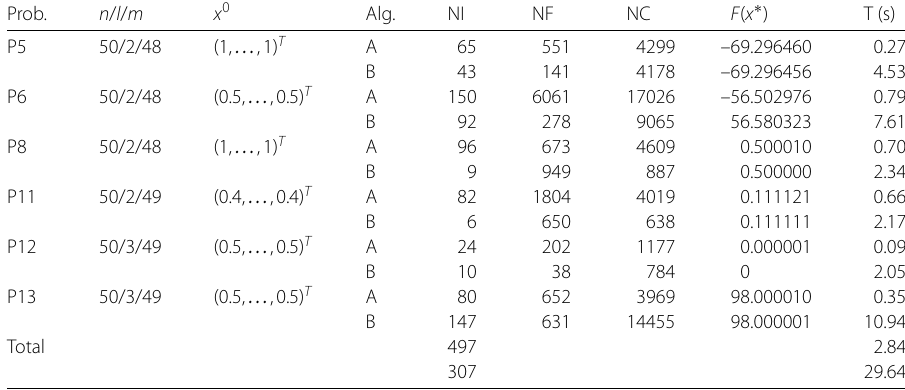
Table 2 Numerical comparisons for Algorithms A and B